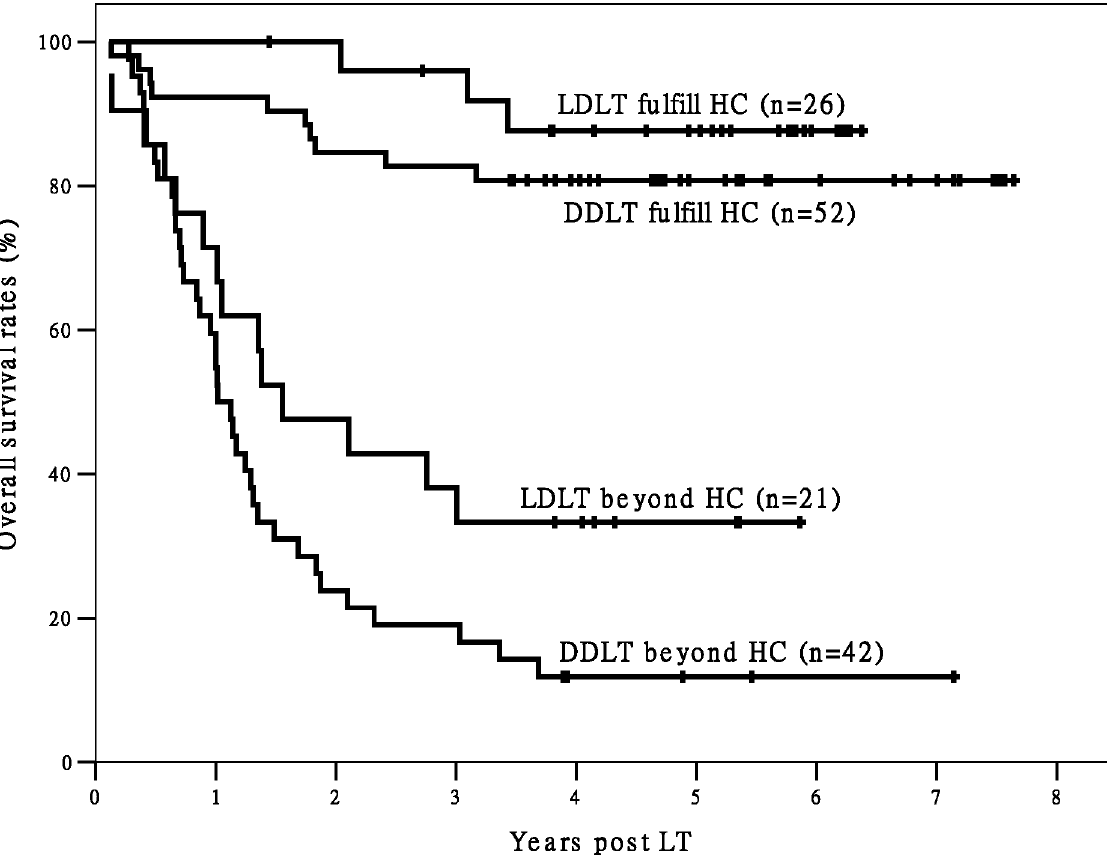
Figure 1. The survival curves of post-LT OS of recipients. There is a significant difference in OS between recipients fulfilling Hangzhou criteria and patients exceeding Hangzhou criteria (P , 0.05). There is no significant difference in OS between different transplant types within Hangzhou criteria (P . 0.05). There is also no significant difference in OS between different transplant types beyond Hangzhou criteria (P=0.065). Abbreviation: OS, overall survival; HC, Hangzhou criteria; LDLT, living donor liver transplantation; DDLT, deceased donor liver transplantation; LT, liver transplantation;